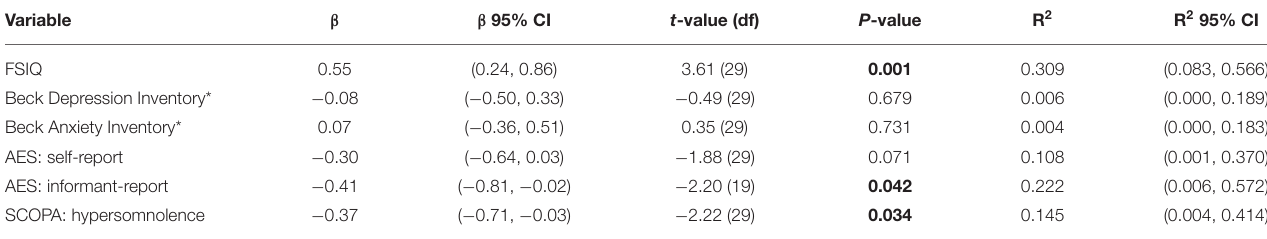
TABLE 4 | Cerebral white matter FA as a predictor of clinical outcomes in DM1 a . Variable